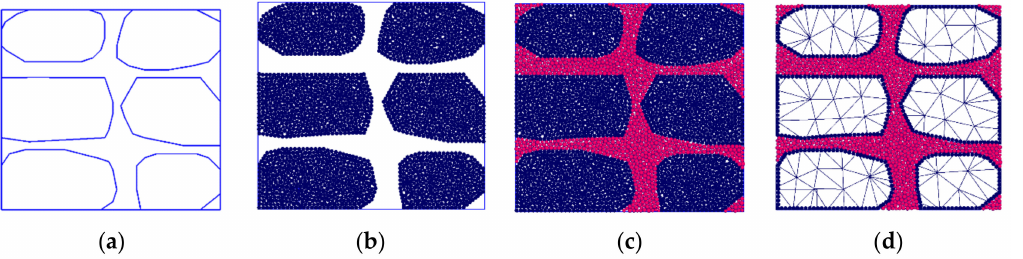
Figure 4. Discretization of a stone masonry wall adapted from [13]. ( a ) Rubblestone masonry wall; ( b ) Stone discretization; ( c ) Mortar discretization; ( d ) Stone particle discretization replaced by inner finite element mesh; only boundary particles are